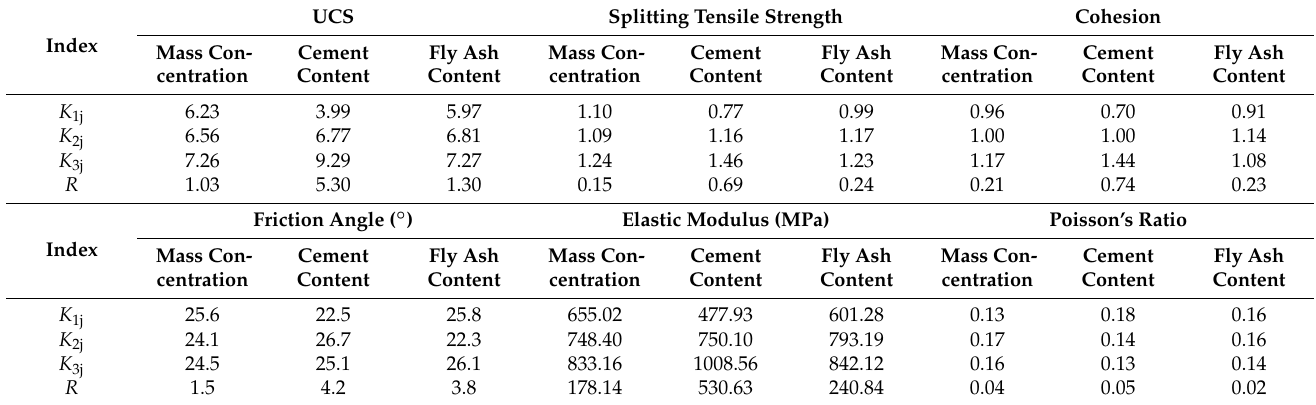
Table 8. Range analysis of factors influencing mechanical properties of gangue paste